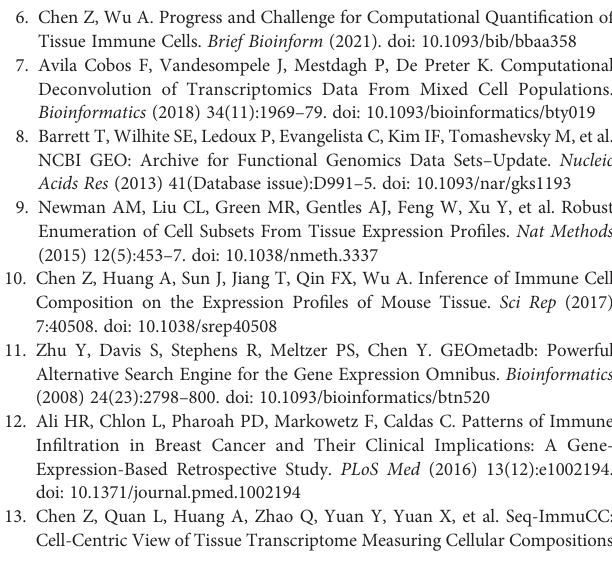
Supplementary Figure 1 | An overview for transcriptome datasets selection and fi ltering process. Supplementary Figure 2 | An introduction for the functions and results of Search module and the Analysis module. Supplementary Table 1 | Matrix for the relationship between each immune cell and allsignaturegenes. Inthis table, the markergenes wereindicated as ‘ 1 ’ andthe remaining genes were indicated as ‘ 0 ’